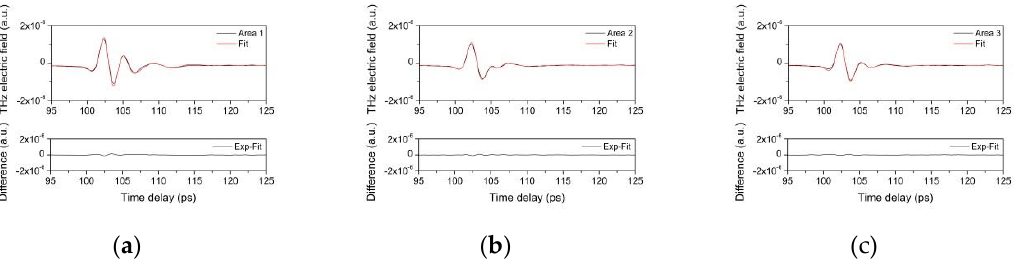
Figure 11. In the upper graphs are reported the THz pulse measured and the corresponding fit; in the lower graph, the differences between the measured and the fit data. ( a ) Reflection pulses from area 1; ( b ) area 2; ( c ) area 3, as schematized in Figure 1 ( a